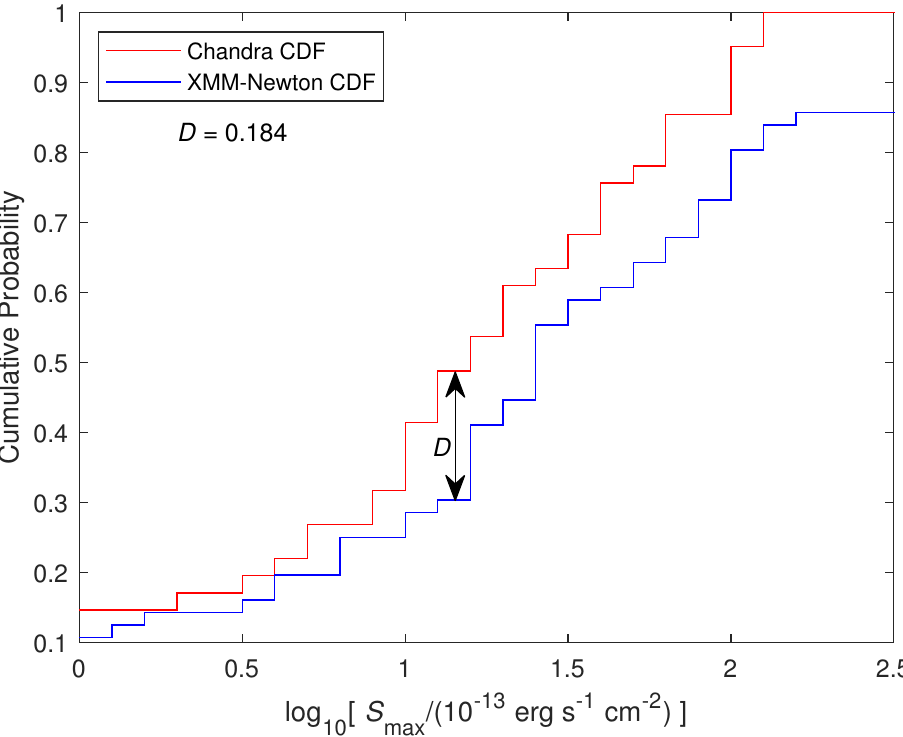
Figure 9. Cumulative distribution functions for the SMC data sets (2 and 3). The KS D statistic is determined by the largest deviation between the two cumulative distributions. We find that D = 0.184, slightly lower than the value determined by the internal M ATLAB routine kstest2 (0.193). Still, the null hypothesis H 0 must be accepted since this D = 0.184 < D crit =